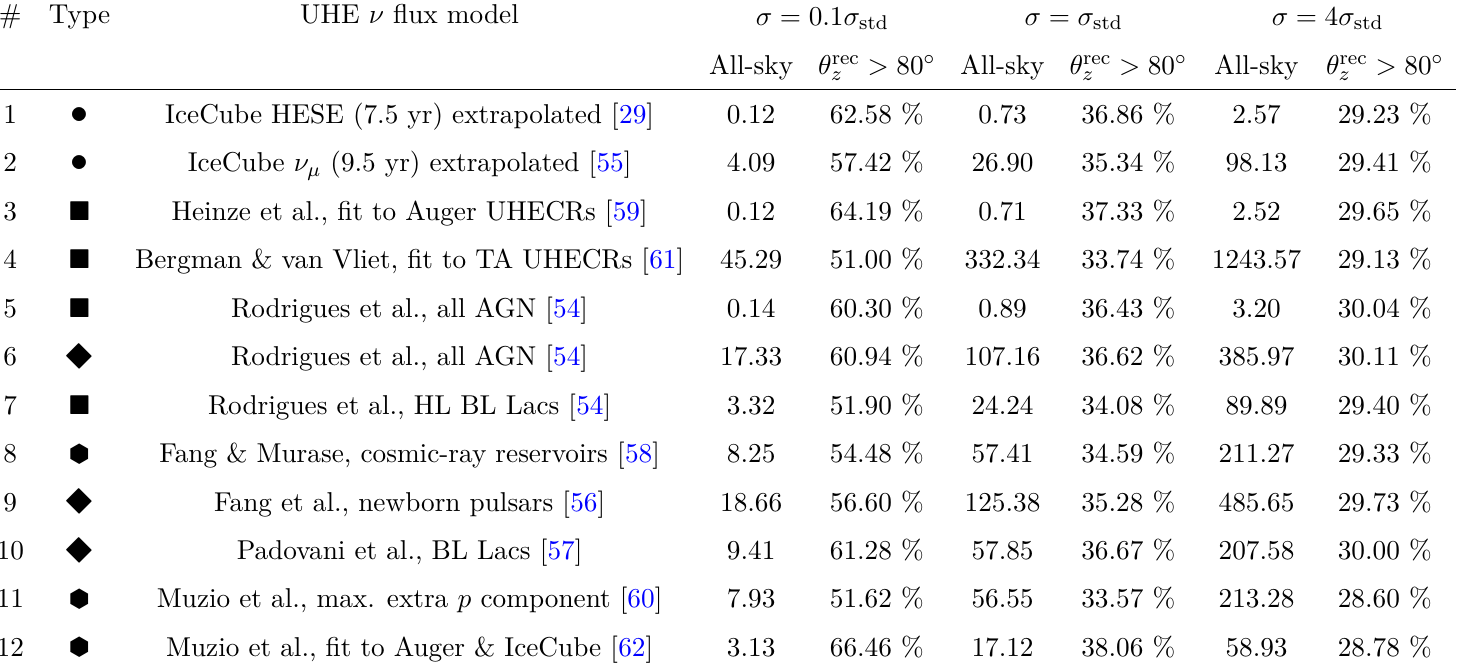
, where α = e, µ, τ . The ν α N = 0 . 1 , with (cid:15) ≡ log ( E rec /E sh ) , and angular (cid:15) 10 sh ≤ 1 ; we show separately the fraction z > 80 ◦ . (To produce our main results, instead we bin finely in reconstructed energy and z